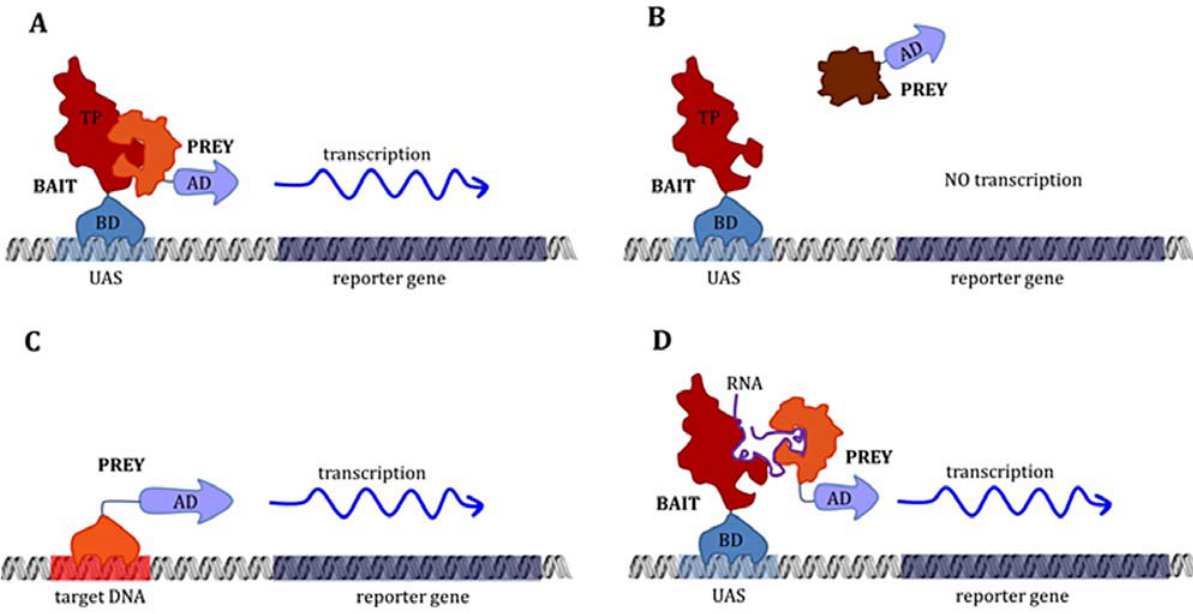
Figure 2. The study of protein-protein interactions using various Y2H systems. Target protein (TP) is fused to DNA-binding domain (BD), forming the bait protein (BAIT). Potential partner protein is fused to transcriptional activation domain (AD), forming the prey protein (PREY). When the two proteins interact (A), the bait recruits the prey to upstream activating sequence (UAS) and transcription of the reporter gene occurs. In the ab- sence of interaction (B), transcription of the reporter gene is not present. Variants of Y2H system: one-hybrid (C) and three-hybrid system